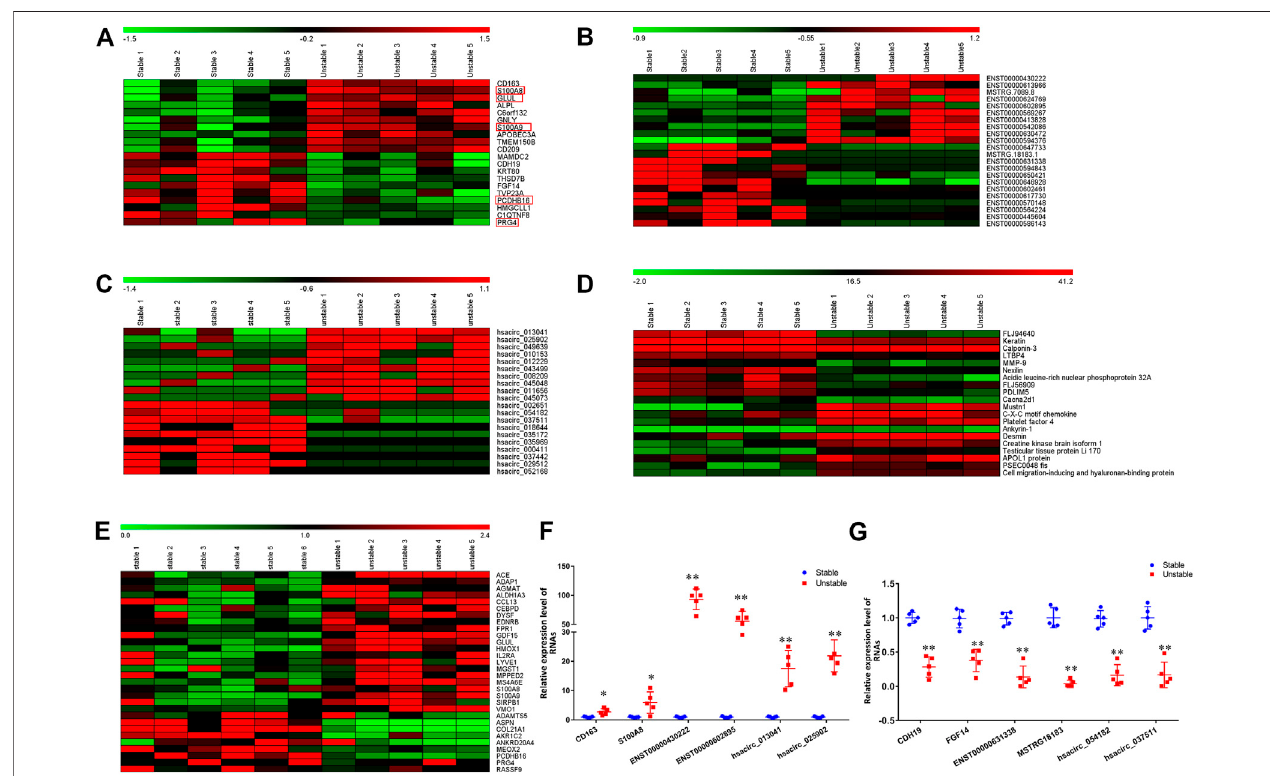
FIGURE 1 | The hierarchical clustering heatmap of 20 DE mRNAs, lncRNAs, circRNAs, and proteins. A – D: The hierarchical clustering heatmap of mRNAs (A) , lncRNAs (B) ,circRNA (C) ,proteins (D) . (E) :Theheatmapofoverlappinggenesbetweencurrentstudyand GSE41571; (F) :theqPCRveri fi cation of6randomlyselected upregulated mRNAs, lncRNAs, and circRNAs. (G) : the qPCR veri fi cation of 6 randomly selected downregulated mRNAs, lncRNAs, and circRNAs. The values (mean ± S.D.from5independentexperiments)arerelativetoStablegroup,whichwassetas1.* p < 0.05,** p < 0.01.Redbox:theoverlappinggenesbetweencurrentstudy (A) and GSE41571